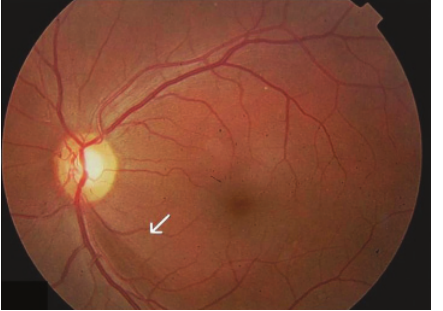
Figure 1 - The inferior localized retinal nerve fiber layer defect (arrow)